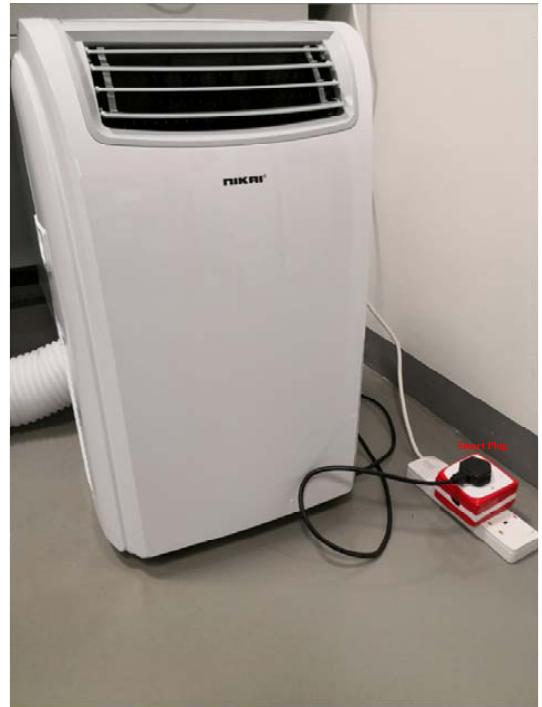
Figure 10. Experimental setup of the air conditioner (AC).